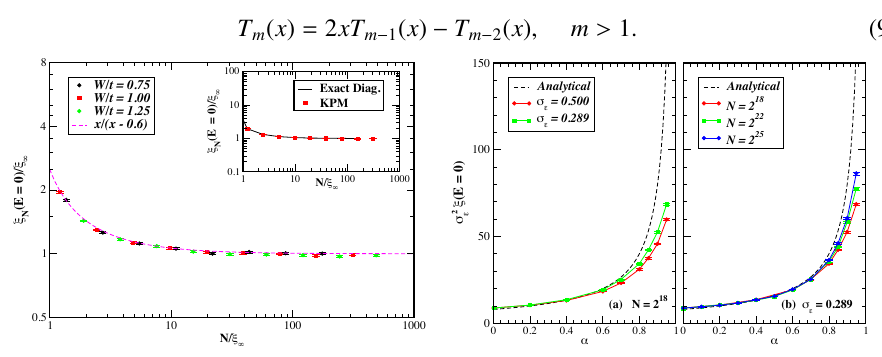
Figure 1. Left panel: Numerical study of the convergence of the localization length to its thermody- namic limit value, i.e. plot of ξ N ( E = 0) /ξ as a function of N /ξ for the 1D Anderson model with ∞ ∞ open boundaries. The data were computed using the KPM with M = 2048 Chebyshev moments and have an estimated error of 1%. The parameter ξ is the analytically calculated localization length in ∞ the perturbative regime for N [8]. In the inset, we confirm the convergence of the KPM estimates → ∞ of the localization length by comparing with the results calculated by an exact diagonalization of the disordered Hamiltonian for W / t = 1. Right panel: Estimates of the normalized localization length σ 2 ε ξ ( E = 0), as a function of α for the de Moura-Lyra model with OBC using the KPM. The computations were carried out for a fixed (a) system of size of N = 2 18 sites and various local variances, σ ε , and (b) σ ε = 0 . 289 (i.e. W = t ) and for various system sizes. Once again, M = 2048 Chebyshev moments were used to obtain an 1% estimated error of convergence. The dashed black curve stands for the Izrailev-Krokhin result (Eq.(7)) and, in (b) , the numerical curves seem to be converging towards this one as N is increased. This reflects the strong finite-size e ff ects which are known to exist in this